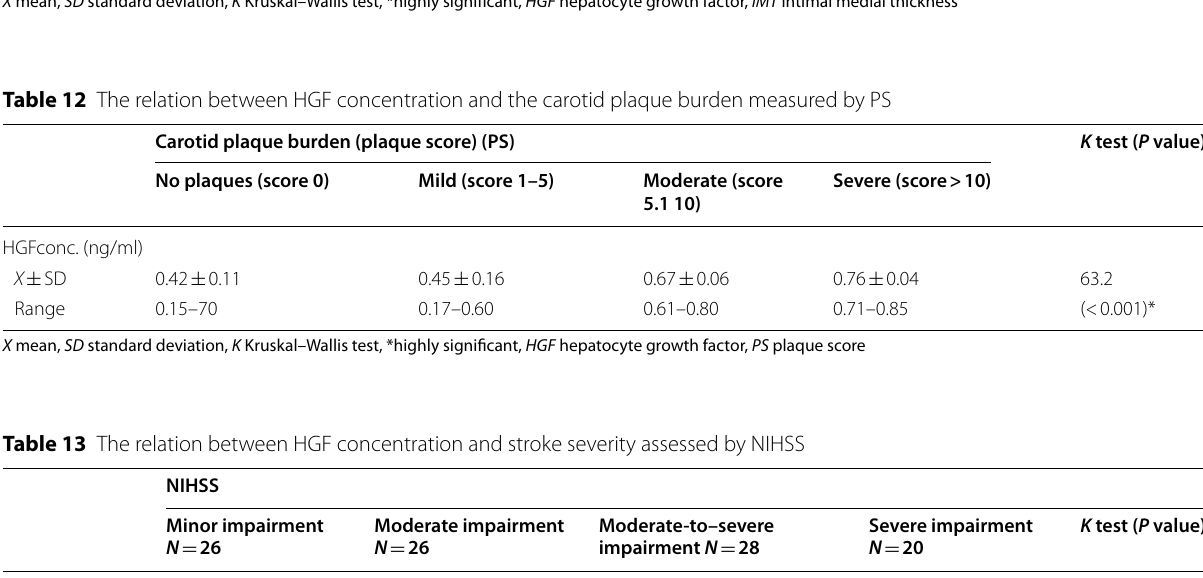
X mean, SD standard deviation, K Kruskal–Wallis test, *highly significant, HGF hepatocyte growth factor, IMT intimal medial thickness